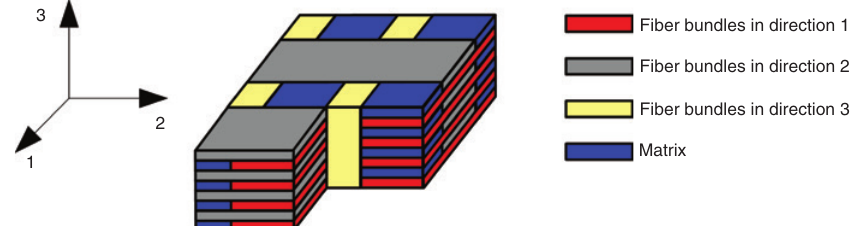
Figure 1: Architecture of 3D carbon-carbon composites.